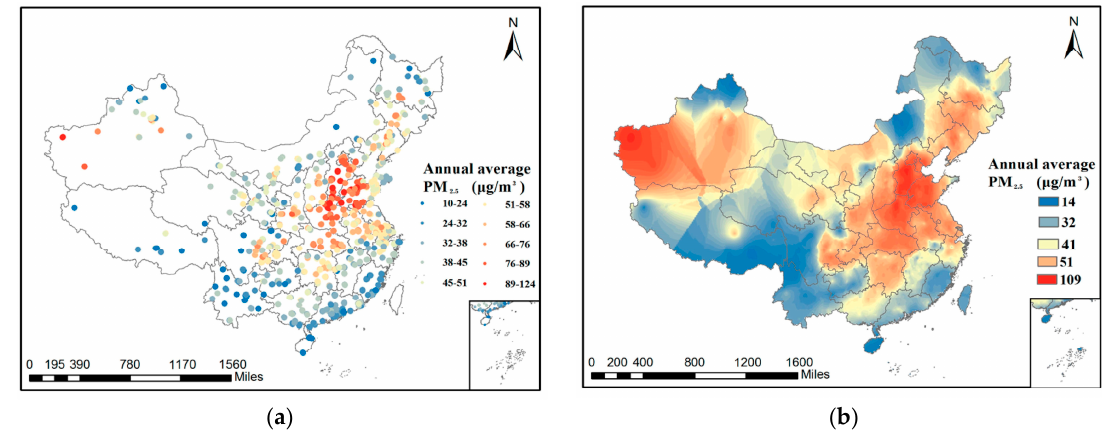
Figure 5. ( a ) Annual PM 2.5 concentration at the monitoring stations in 2015; and ( b ) the distribution of annual average PM 2.5 concentration in China interpolated by EBK.